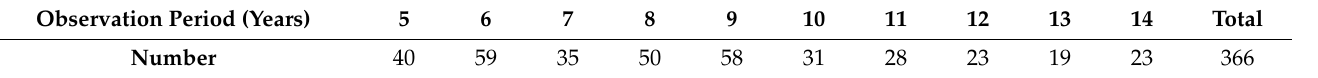
Table 2. Distribution of the observation periods.